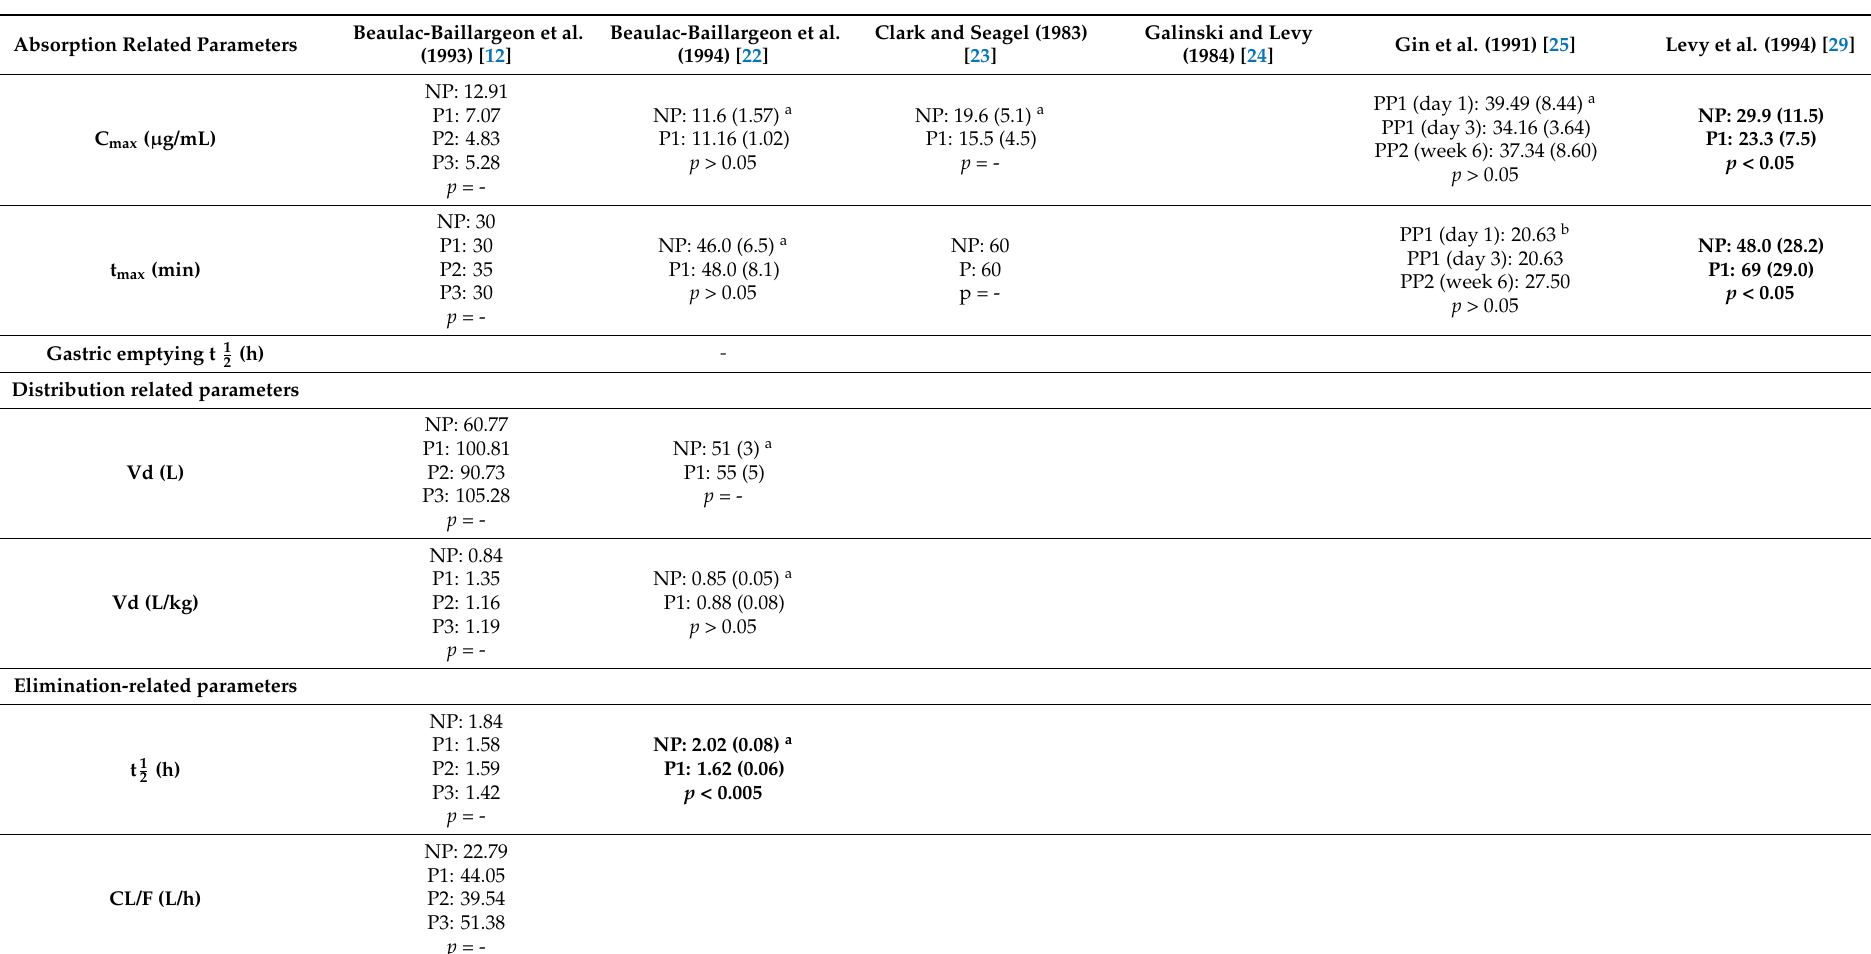
Table 2. Summary of pregnancy-induced changes in the pharmacokinetics, obtained with NCA, of acetaminophen and its metabolites. Studies are presented in alphabetical order by author. Data are given in median [range], mean (SD) unless other use is